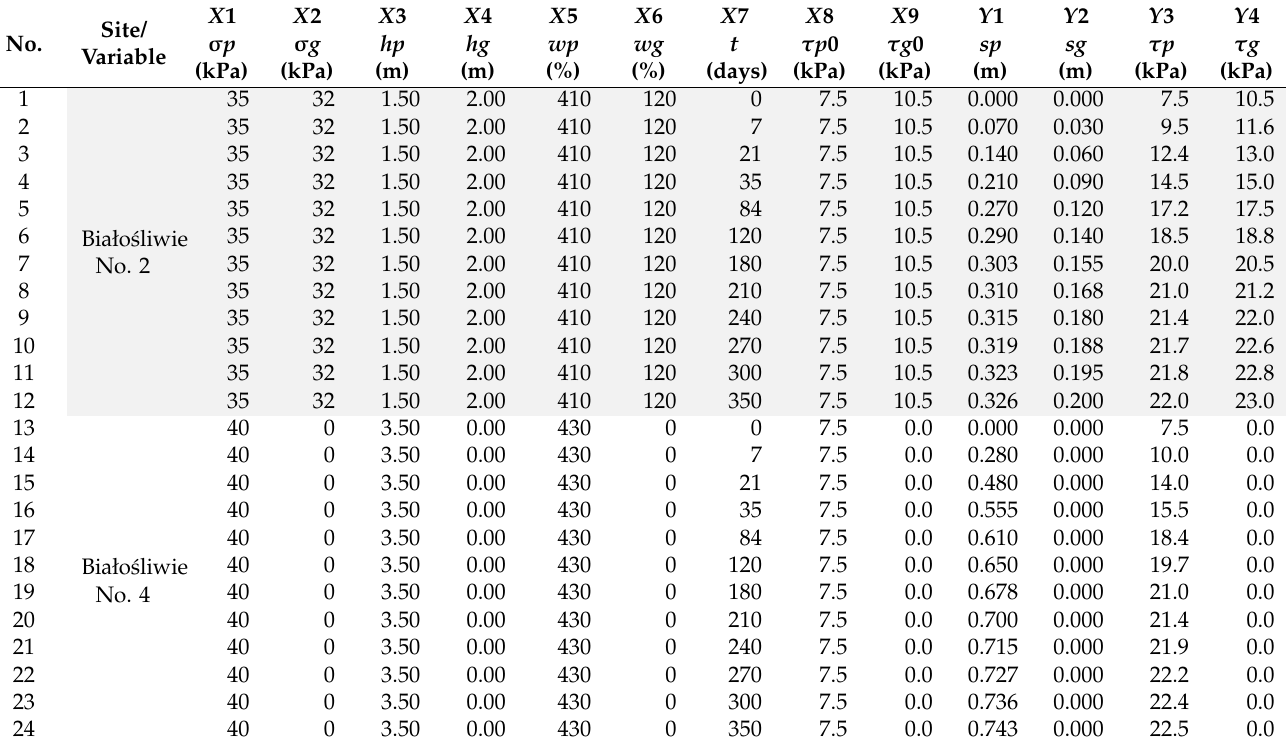
A detailed summary of the test results of the analyzed variables is presented in Table 2. Table 2. Summary of input and output values for the statistical and ANN